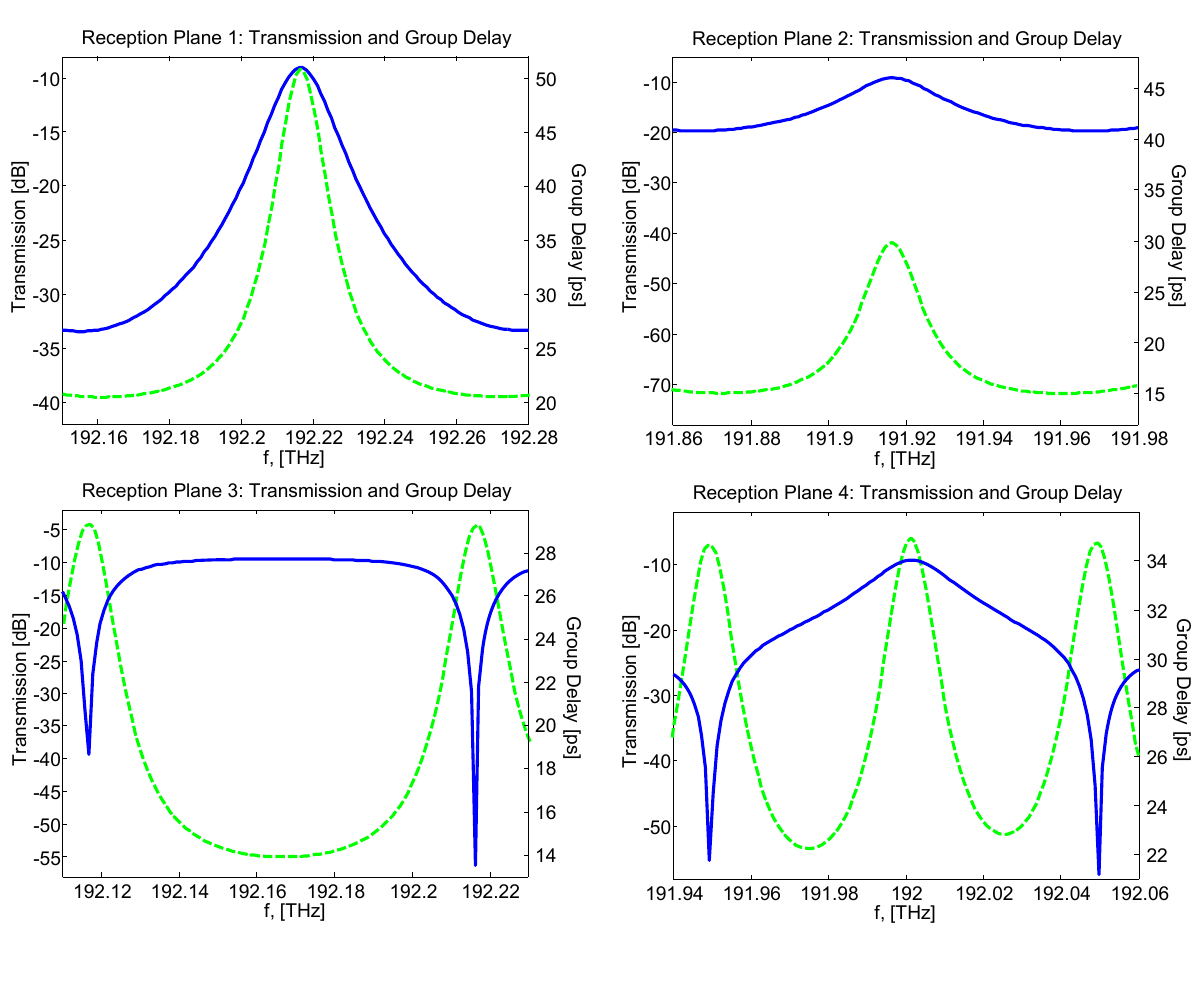
Figure 6. Transfer function “-” and group delay “- -” after the PSC at different